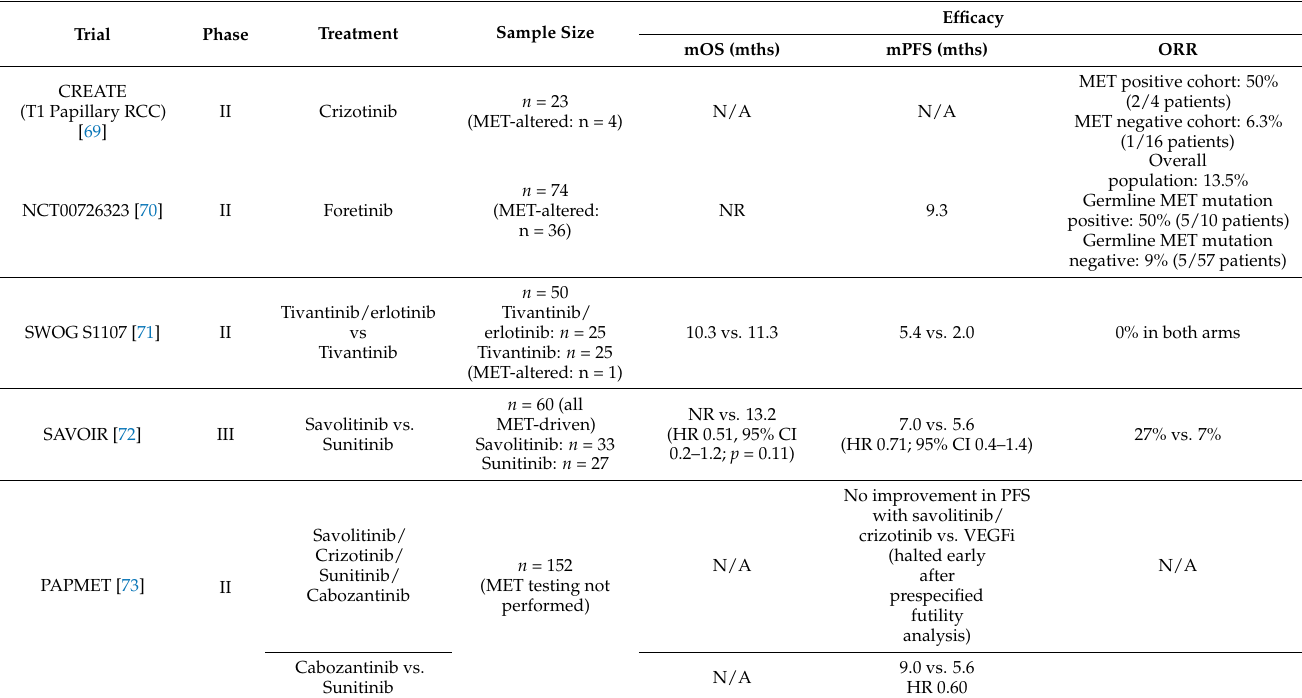
Table 5. MET inhibitor trials in papillary RCC